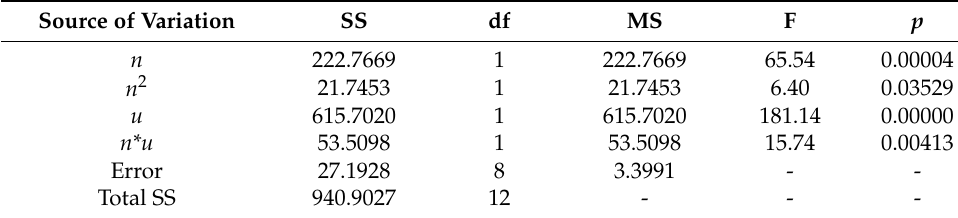
SS—sum of squares, df—number of the degrees of freedom, MS—mean sum of squares, F—values of the test statistic, p -value of probability corresponding to the test statistic value.